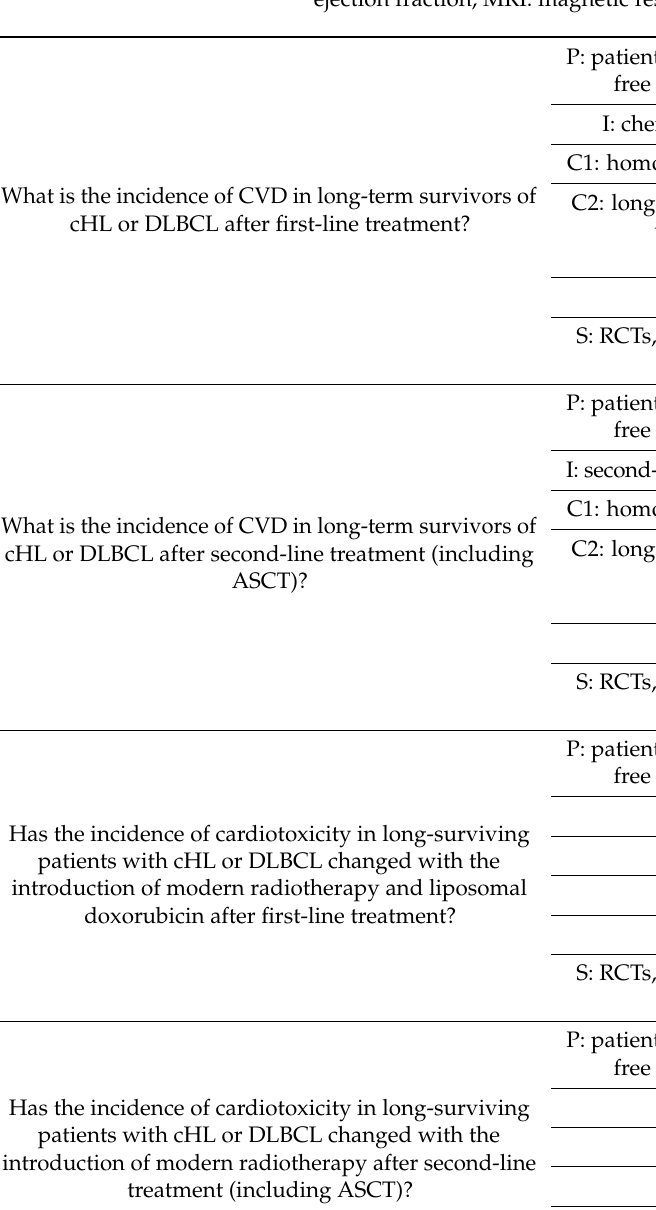
Table 1. Clinical questions and PICOs considered by the review PICO, population, intervention, control, and outcome. cHL, classical Hodgkin lymphoma; DLBCL, diffuse large B-cell lymphoma; ASCT, autologous stem cell transplant; RCTs: randomized controlled trials; LVEF: left ventricular ejection fraction; MRI: magnetic resonance